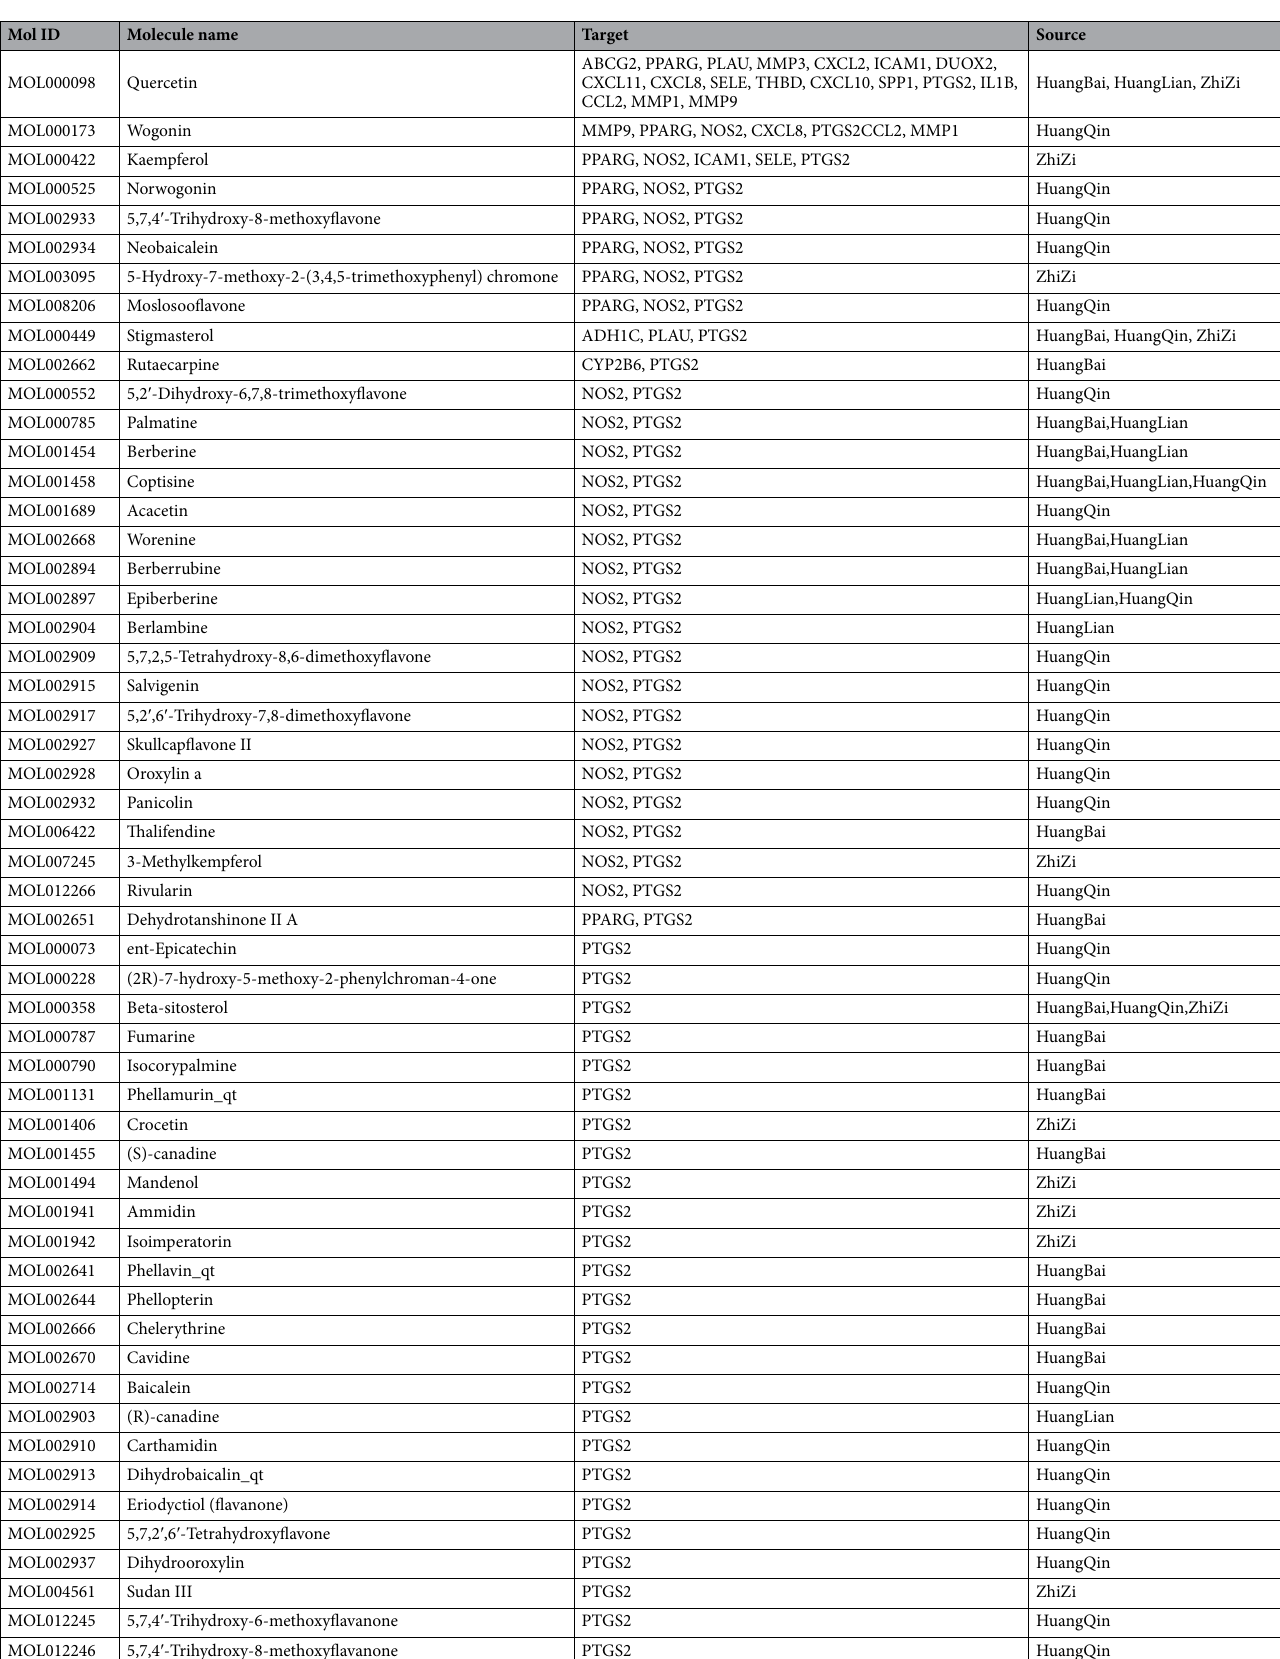
Table 2. Common targets related to active